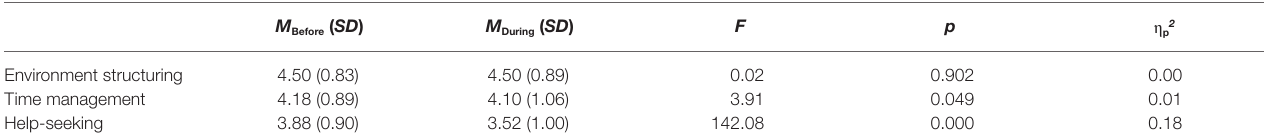
TABLE 3 | Descriptive statistics and results of a repeated measures multivariate ANOVA (MANOVA) comparing intended and actual use of external resource management strategies. M Before ( SD